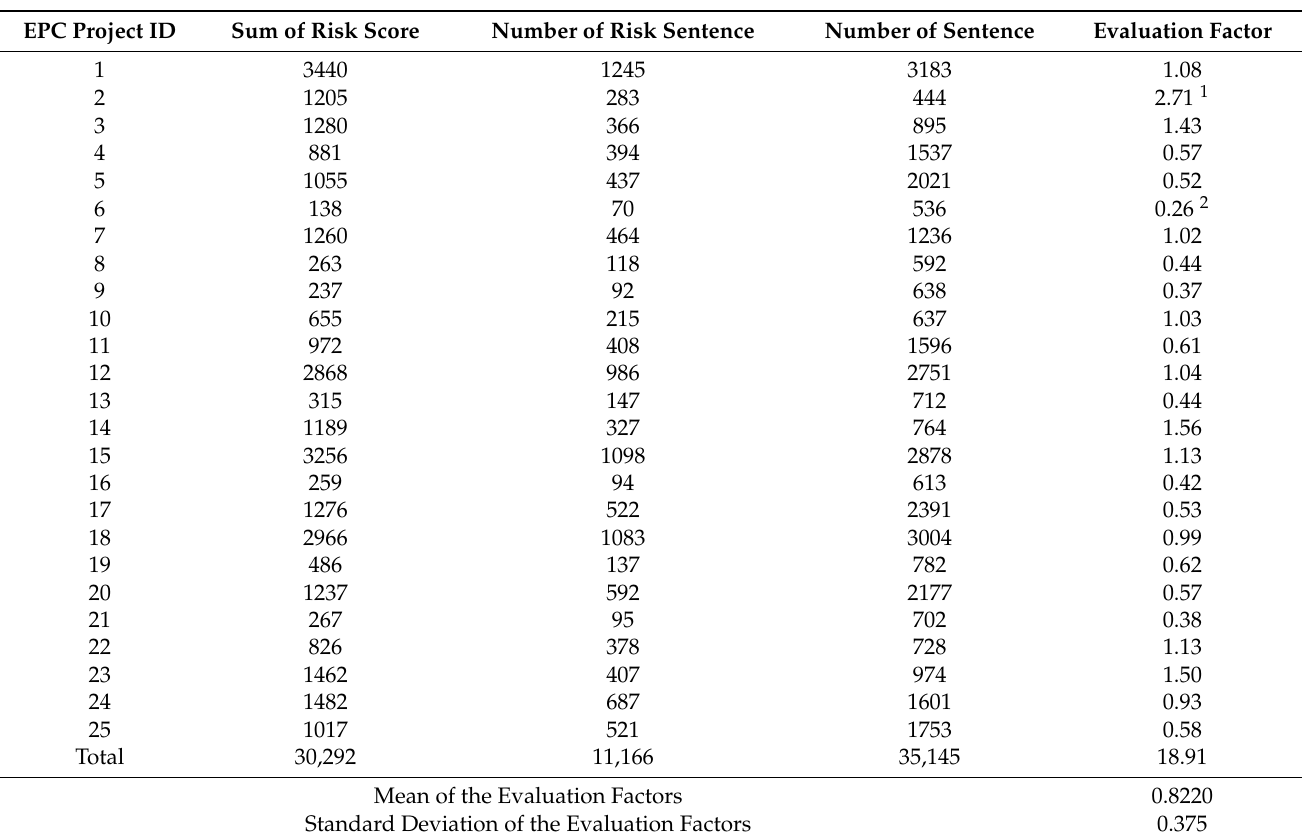
Table 2. Normalization result of evaluation scores for 25